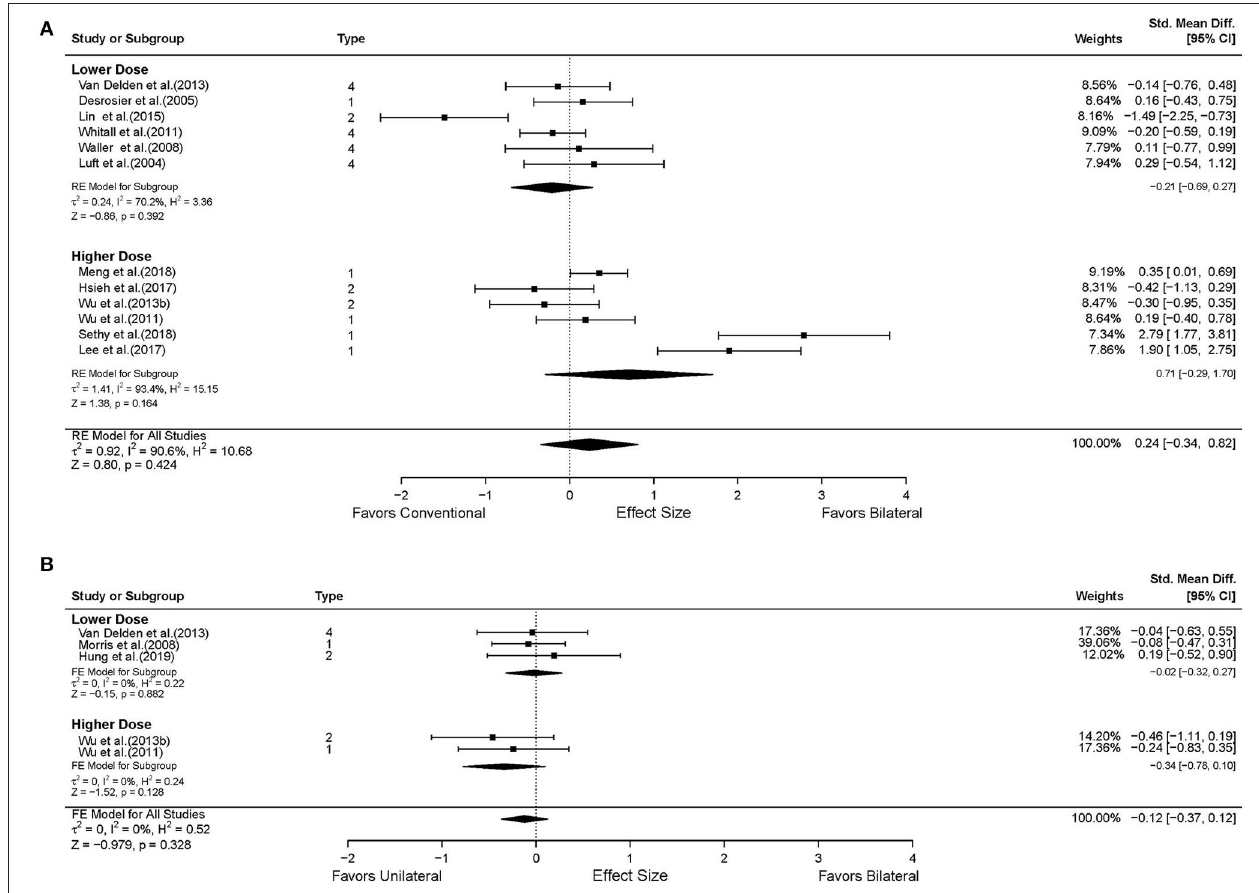
FIGURE 6 | The effects of intervention dose on the UE functional performance. (A) BAT vs. CT; (B) BAT vs. UAT. 1 = bilateral functional training Test (BFTT); 2 = bilateral robot-assisted training (BRAT); 3 = bilateral arm training with rhythmic auditory cueing (BATRAC); 4 = mirror therapy (MT); BAT, bilateral arm training; CI, confidence interval; CT, conventional therapy; FE, fixed-effects; RE, random-effects; Std. Mean Diff., standardized mean difference; UAT, unilateral arm